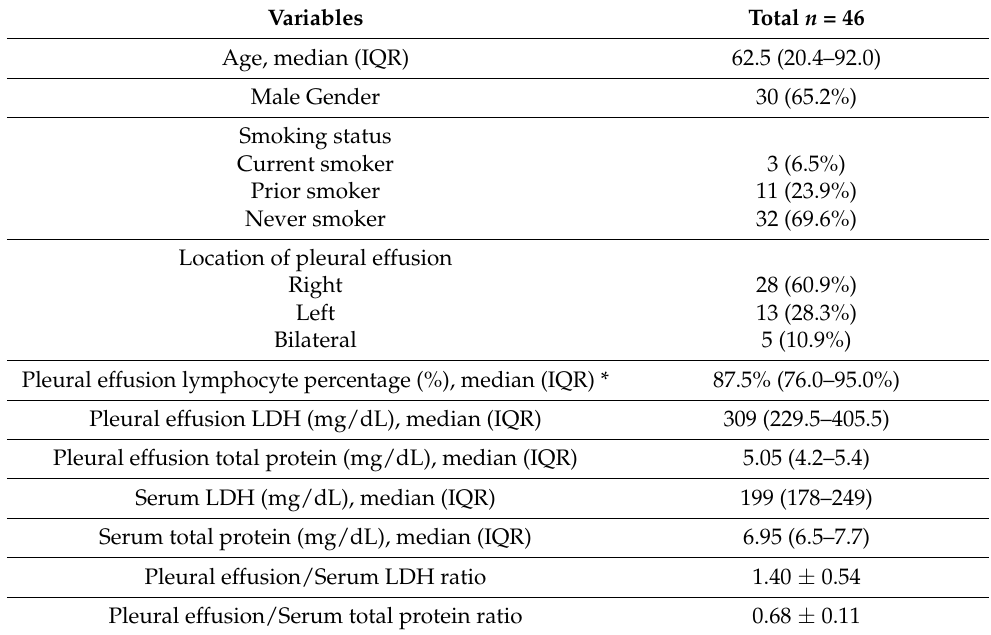
Table 1. Baseline characteristics of the TB pleurisy